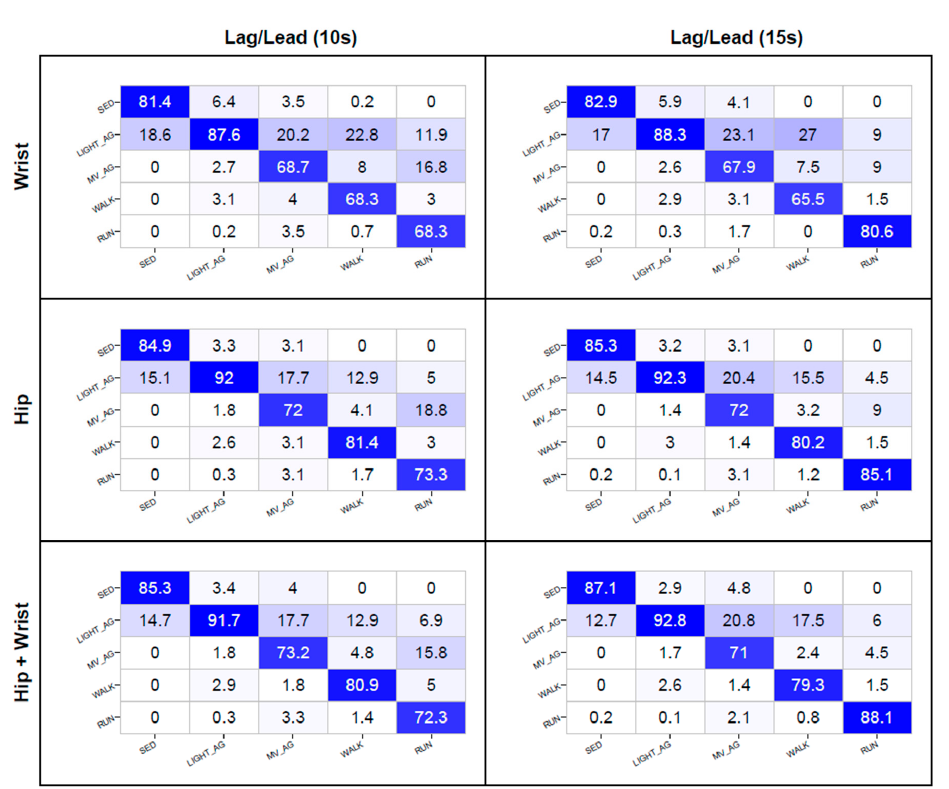
Figure 2. Confusion matrices for physical activity classification from the wrist, hip, and combined hip and wrist placement for lag / lead 10 and 15 s window models. The columns represent observed; rows represent predictions; bold represents correct predictions; SED = sedentary; LIGHT_AG = light physical activity and games; MV_AG = moderate to vigorous physical activity and games; WALK = walking; RUN = running.